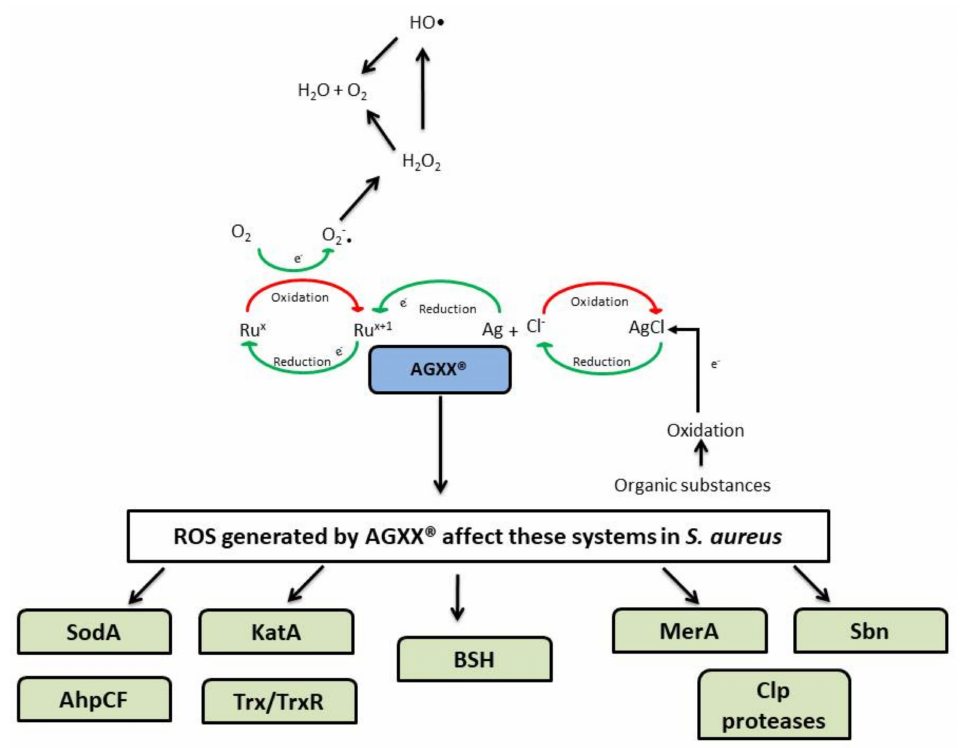
Figure 1. Mechanism of action of AGXX ® in S. aureus . The mode of action of AGXX ® is based on two inter-connected redox cycles resulting in its antimicrobial effect and self-renewal. In the first cycle, the chloride (Cl − ) from the electrolyte oxidizes elementary silver (Ag 0 ) to form silver chloride